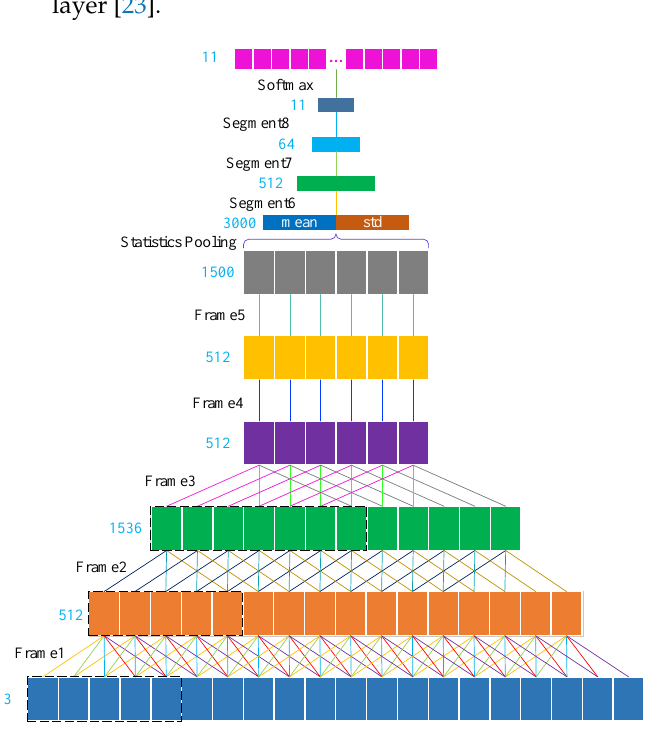
Figure 6. The DNN used for x − vector extraction. Lines with the same color between each layer represent the same weight. “mean” and “std” denote the mean and standard deviations of